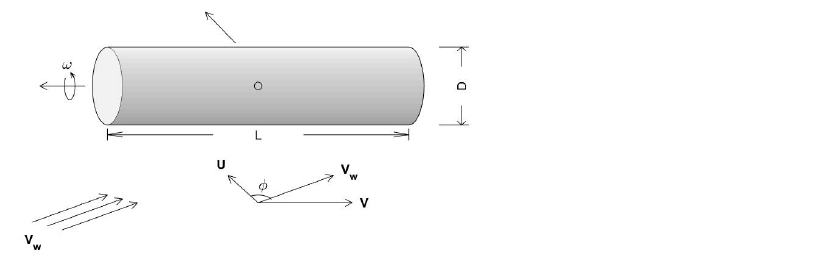
Figure 8. Roll of a cylindrical object on the seafloor with large aspect ratio forced by the combination of ocean currents and bottom wave orbital velocity. Here, ( π /2 − ϕ ) is the angle between V w and the main axis of the cylinder.